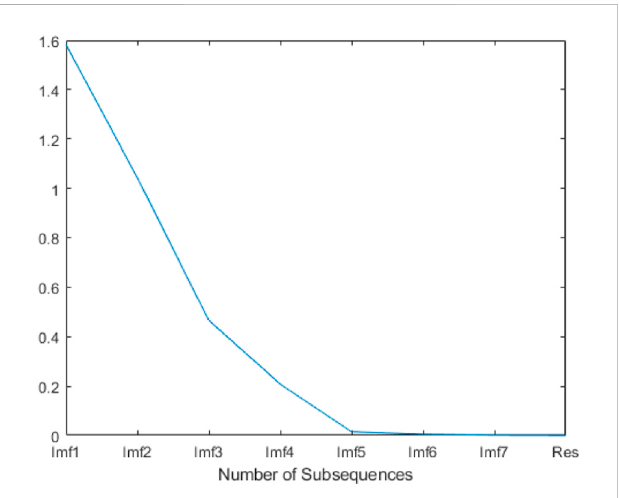
FIGURE 13 Fuzzy entropy analysis of the decomposition results of Case 2.